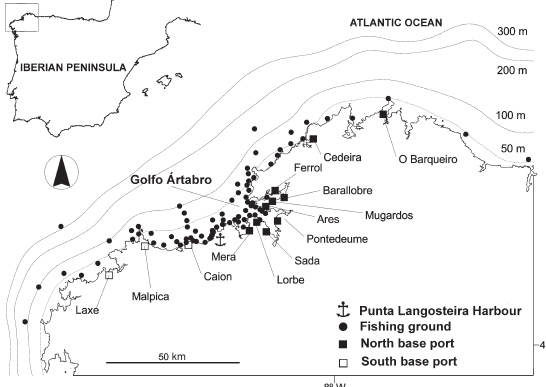
Fig . 1. – Study area in Galicia (nW Spain). the future port of Punta langosteira, the identified fishing grounds and the base ports of the studied fleet are